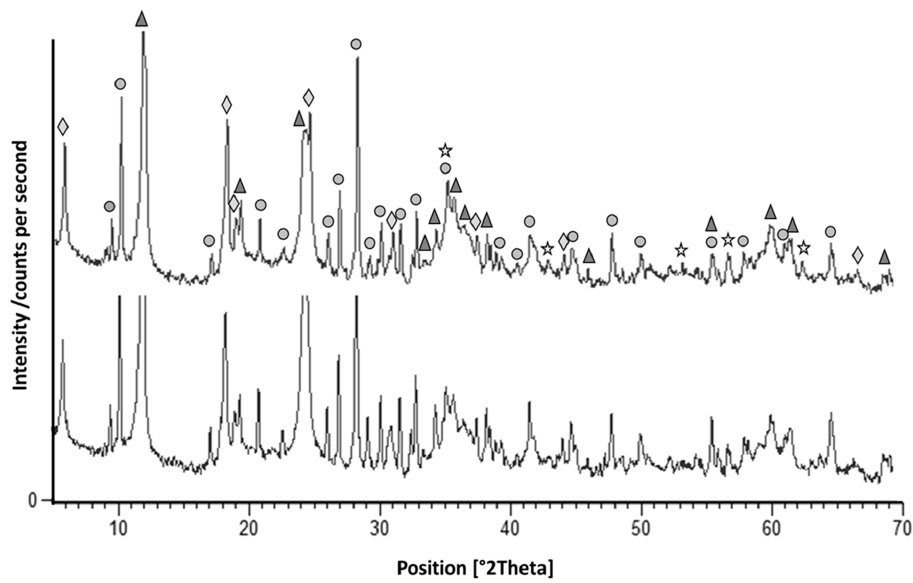
Figure 2. X-ray powder diffraction analysis (XRPD) patterns of selected bulk and vein serpentinite samples. Legend: filled triangle = serpentine; filled circle = tremolite; filled rhombus = clinochlore; star = magnetite. According with [50,52,54], our spectra, symmetric, and antisymmetric Si-O-Si stretching modes of fibrous amphibole give peaks at about 1062 and 675 cm − 1 , the second one is also the strongest peak. O-H-O vibrations produce one other strong peaks at about 223 cm − 1 (Figure 3a). In the OH vibrational region, amphibole shows two peaks, the most intense at 3675–3673 cm − 1 (Mg; Mg; Mg), and the second at 3660–3663 cm − 1 (Mg; Mg; Fe) obtained by Raman spectroscopy [54] (Figure 3b). Therefore, the number and relative intensity of these bands represent pure tremolite and almost pure tremolite (Fe-tremolite) with a small percentage of Fe 2+ (Figure 3b,c).